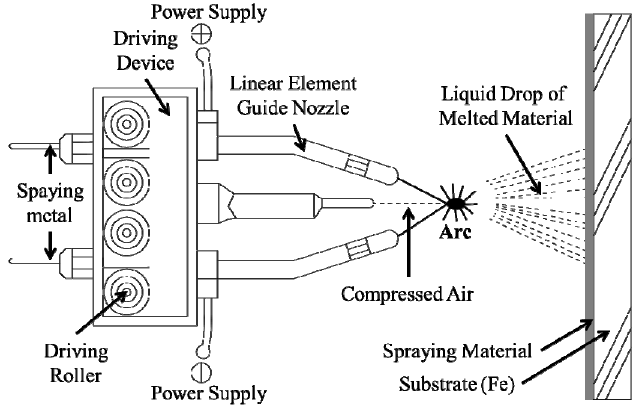
Figure 1. Schematic diagram of the arc thermal metal spay process.